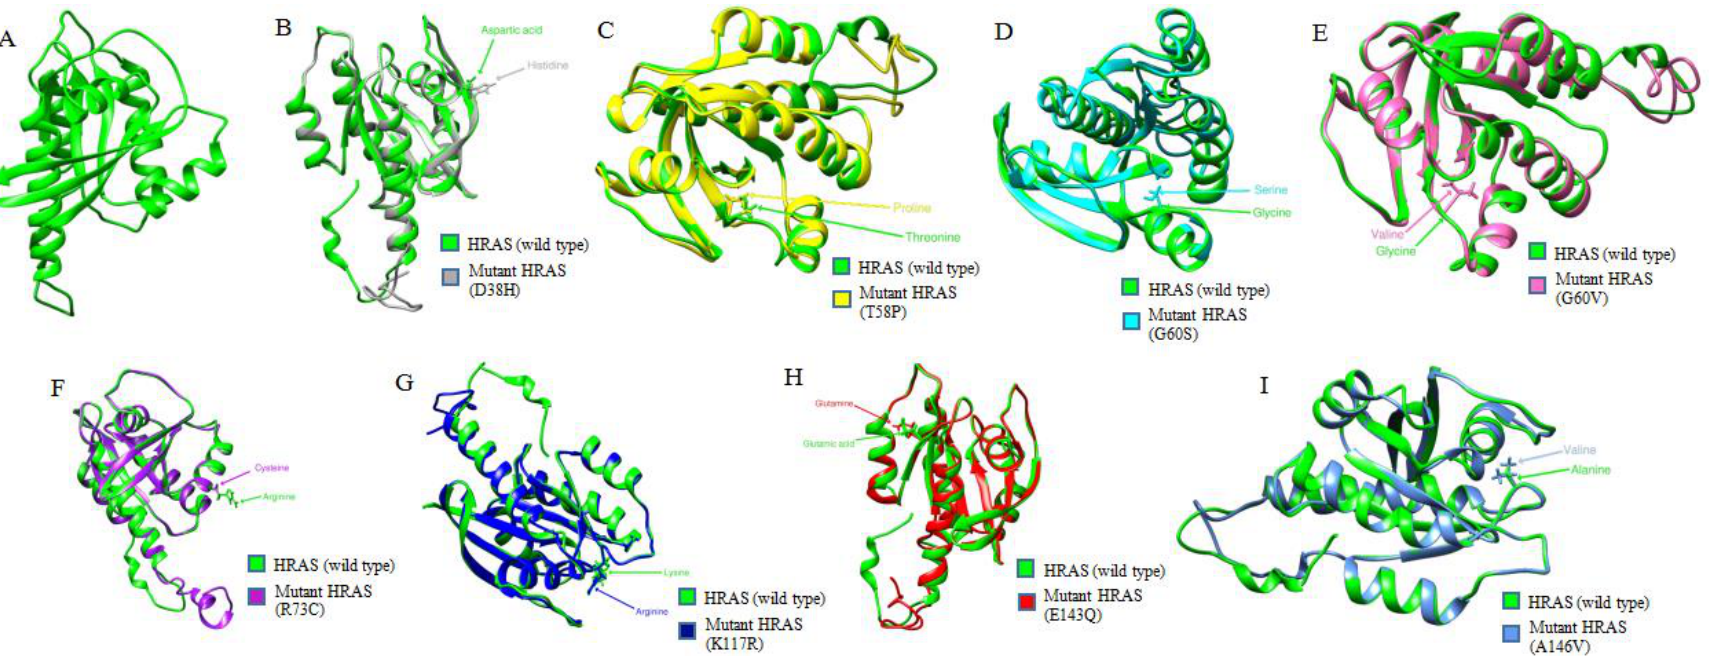
Figure 2. Comparison of wild-type HRAS protein structure with its mutant forms. ( A ) 3D model of wild-type HRAS protein. ( B ) Superimposed structures of wild-type HRAS protein and its mutant with mutation from Aspartic acid to Histidine at position 38. ( C ) Superimposed structures of wild-type HRAS protein and its mutant with mutation from Threonine to Proline at position 58. ( D ) Superimposed structures of wild-type HRAS protein and its mutant with mutation from Glycine to Serine at position 60. ( E ) Superimposed structures of wild-type HRAS protein and its mutant with mutation from Glycine to Valine at position 60. ( F ) Superimposed structures of wild-type HRAS protein and its mutant with mutation from Arginine to Cysteine at position 73. ( G ) Superimposed structures of wild-type HRAS protein and its mutant with mutation from Lysine to Arginine at position 117. ( H ) Superimposed structures of wild-type HRAS protein and its mutant with mutation from Glutamic acid to Glutamine at position 143. ( I ) Superimposed structures of wild-type HRAS protein and its mutant with mutation from Alanine to Valine at position 146.